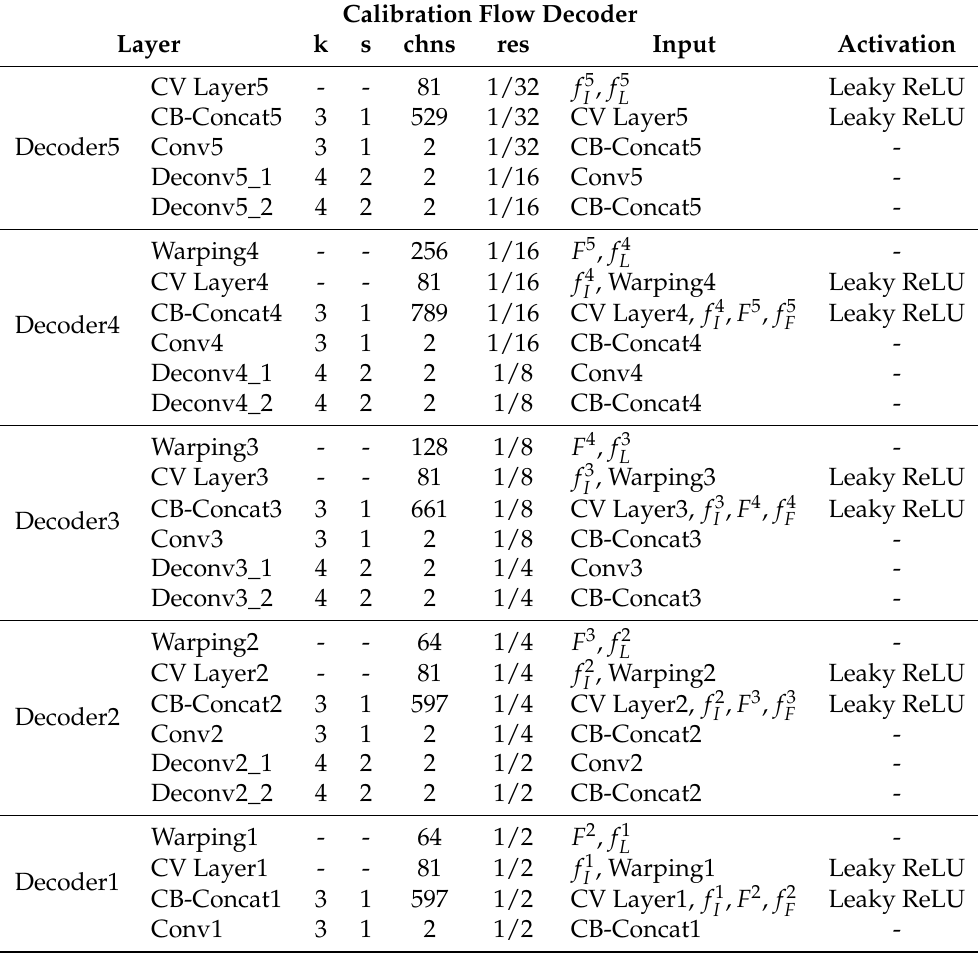
Table 1. Network architecture of the calibration flow decoder network of our proposed